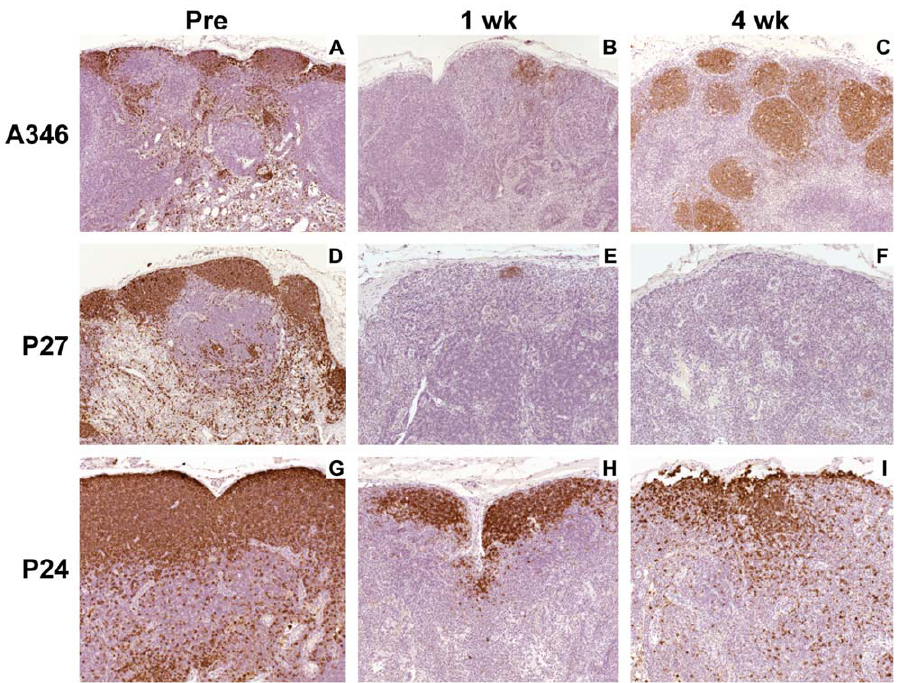
Figure 2. Only partial depletion of B cells in lymphatic tissues of CD8 + and CD20 + lymphocyte-depleted AGM but not of PTM. Immunohistochemical (IHC) detection of CD20 + B cells in sequential lymph node biopsies from a representative vervet AGM (A346) collected pre- inoculation ( A ), one week p.i. ( B ), and four weeks p.i. ( C ). Representative IHC staining for CD20 is shown on two PTM with different clinical courses. PTM P27 was representative of the pattern seen in the three PTM that showed efficient depletion of CD20 + B cells at one week p.i. that was irreversible at four weeks p.i. ( D, E, and F ). PTM P24 only had a partial depletion of CD20 + B cells at one week p.i. and near normal CD20 + B cell levels at four weeks p.i. ( G, H, and I ).